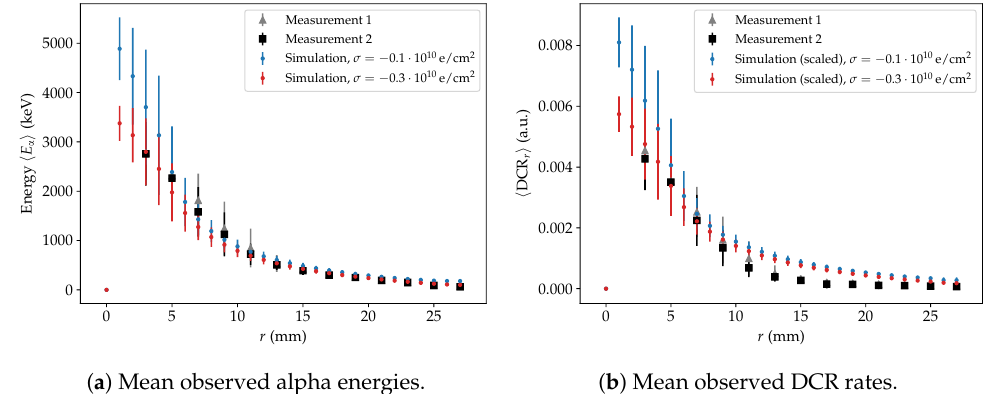
0.1, 0.3 10 10 e/cm 2 . − − ×